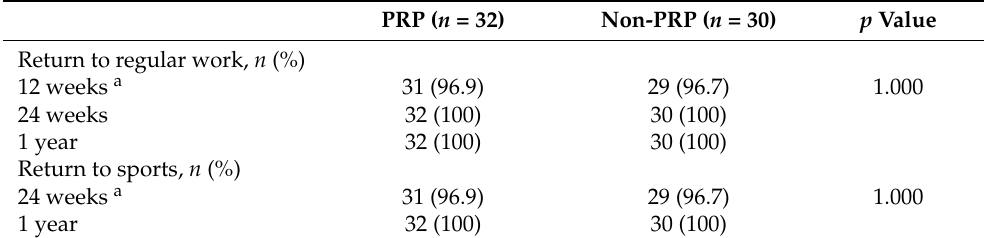
Table 2. Return to work and sports based on